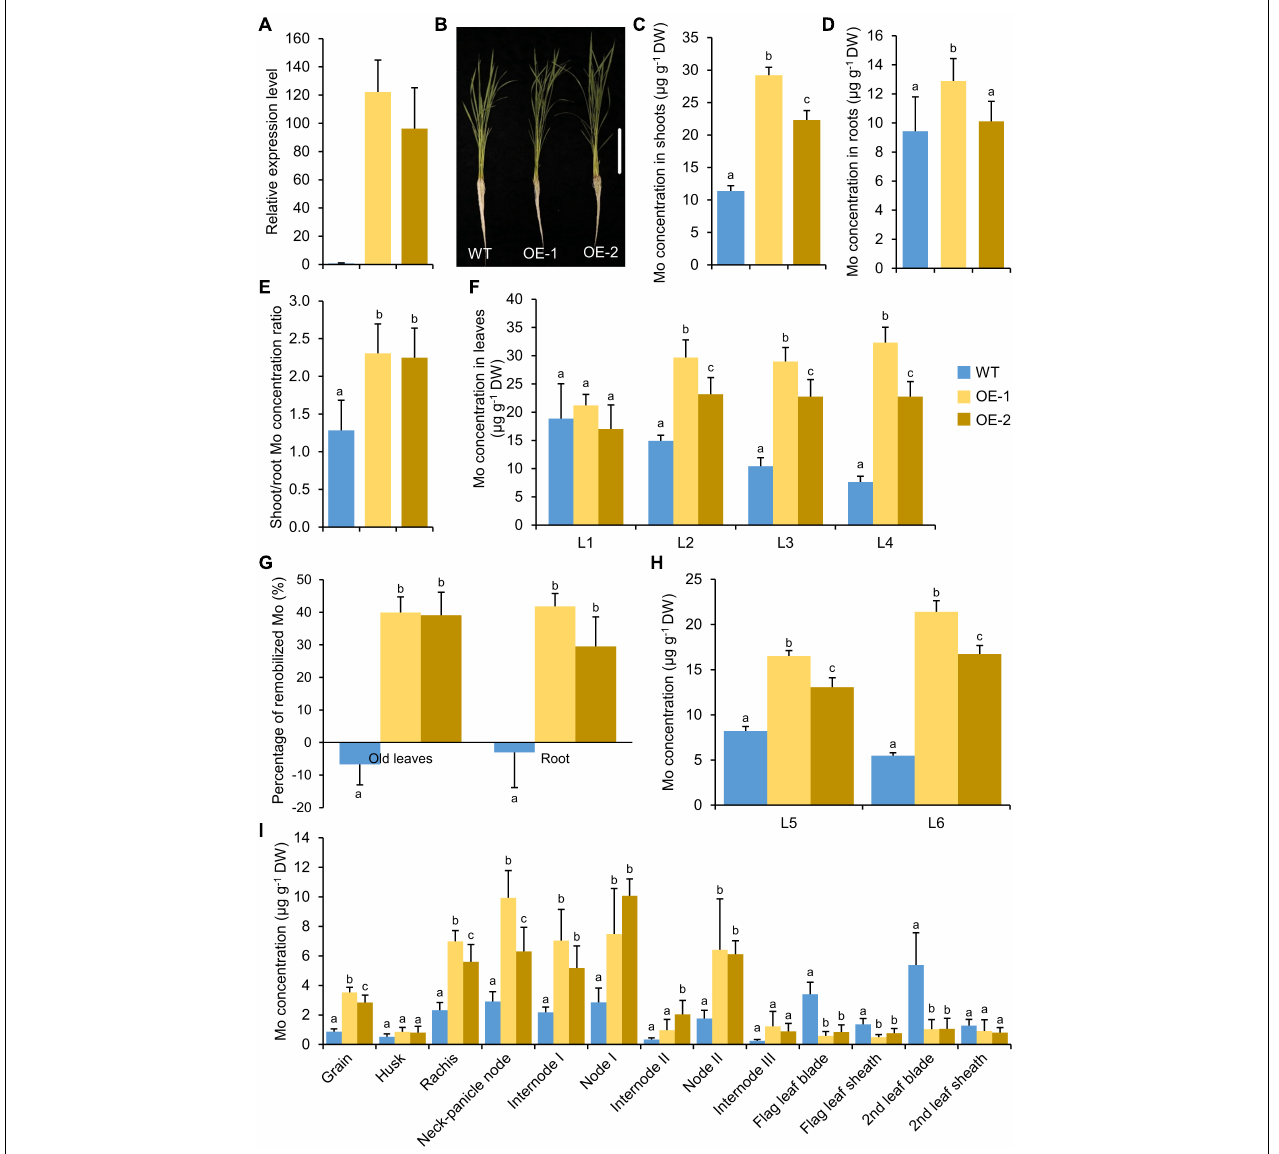
FIGURE 6 | Overexpression of OsMOT1;2 enhances root-to-shoot translocation and Mo remobilization. (A) Relative expression level of OsMOT1;2 in WT and OsMOT1;2 overexpression lines. The relative expression level of OsMOT1;2 was determined by qRT-PCR and was normalized to the housekeeping gene OsActin and shown as 2 − (cid:49) Ct . (B) The growth phenotype of WT and two OsMOT1;2 overexpression lines cultured with nutrient solution with 10 nM Mo at four leaves seedling stage. Vertical bar, 10 cm. (C–E) The Mo concentrations in shoots (C) , roots (D) , and the shoot/root concentration ratio (E) of the seedlings described in (B) . (F) The Mo concentrations in different leaves of the seedlings in (B) . L1, L2, L3, and L4 represent the first to fourth leaves. (G) The percentage of Mo in roots and older leaves (the first to fourth leaves; L1–L4) that were remobilized to new leaves (the fifth and sixth leaves; L5 and L6). The percentage of remobilized Mo in roots or old leaves was calculated by the difference of Mo concentrations between the four leaves stage and six leaves stage and divided by the concentrations at the four leaves stage. (H) The Mo concentrations in the fifth and sixth leaves (L5 and L6) at the six leaves stage were newly grown after Mo-depleted treatment. (I) The Mo concentrations in various tissues of WT and two independent OsMOT1;2 overexpression lines (OE-1 and OE-2). Data in (A,C–H) are presented as means ± SD with three (A) or six (C–I) biological replicates. Columns with different letters in (A,C–H) indicate significant differences at P < 0.05 (Tukey’s honestly significant difference